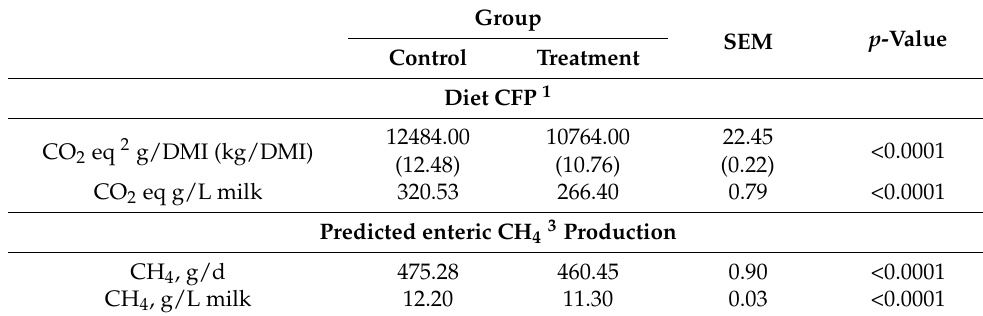
Table 9. Environmental impact: carbon footprint (CFP) and predicted enteric CH 4 production in the two